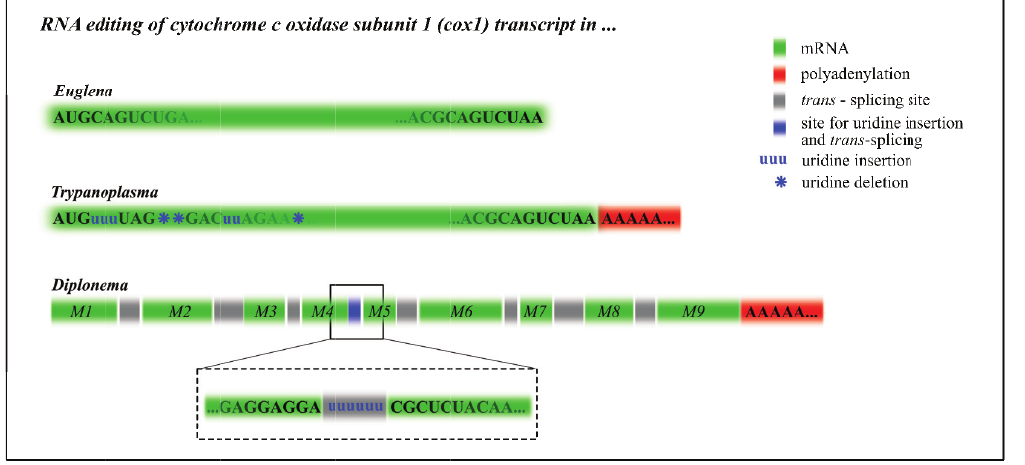
Figure 4. The comparison of RNA processing of the cox1 transcript in representative euglenozoans. In contrast to Trypanoplasma borreli and Diplonema papillatum , the cytochrome c oxidase subunit 1 (cox1) transcript of Euglena gracilis (in green) does not undergo RNA editing, splicing, or polyadenylation prior to its translation. In Trypanoplasma , cox1 undergoes RNA editing in the form of numerous uridine insertions (small blue “u”) and deletions (blue star), followed by polyadenylation (in red). The Diplonema cox1 transcript is formed by trans -splicing of nine small fragments called modules M1 thru M9 (in green), which is accompanied by the insertion of six uridines between the modules M4 and M5. Finally, the transcript is polyadenylated and translated on mitochondrial ribosomes.